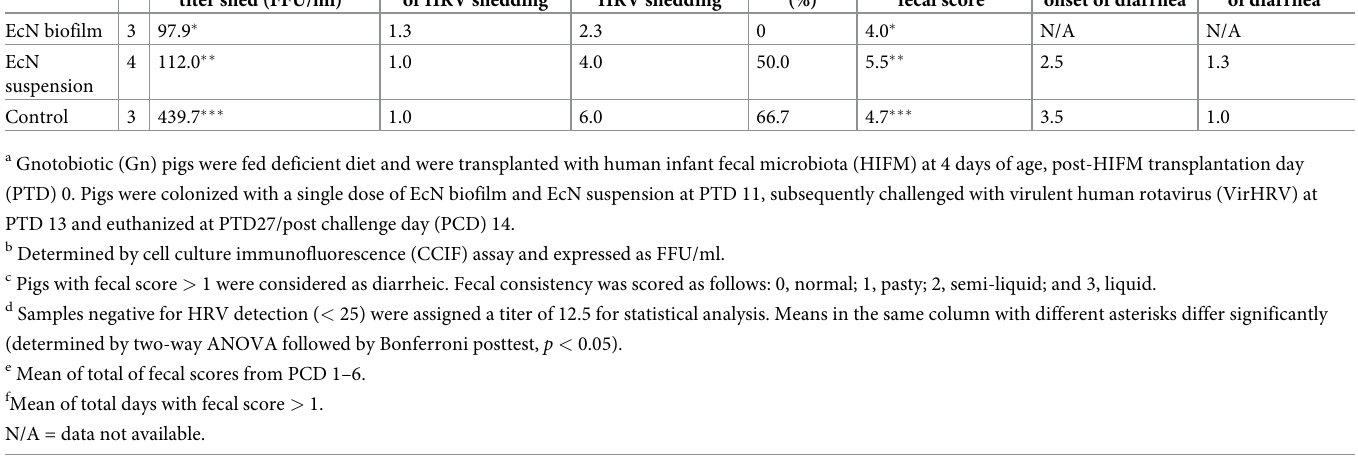
Table 1. Summary of fecal VirHRV shedding and diarrhea following VirHRV challenge (PCD 1–6). HRV Shedding b Diarrhea c Groups